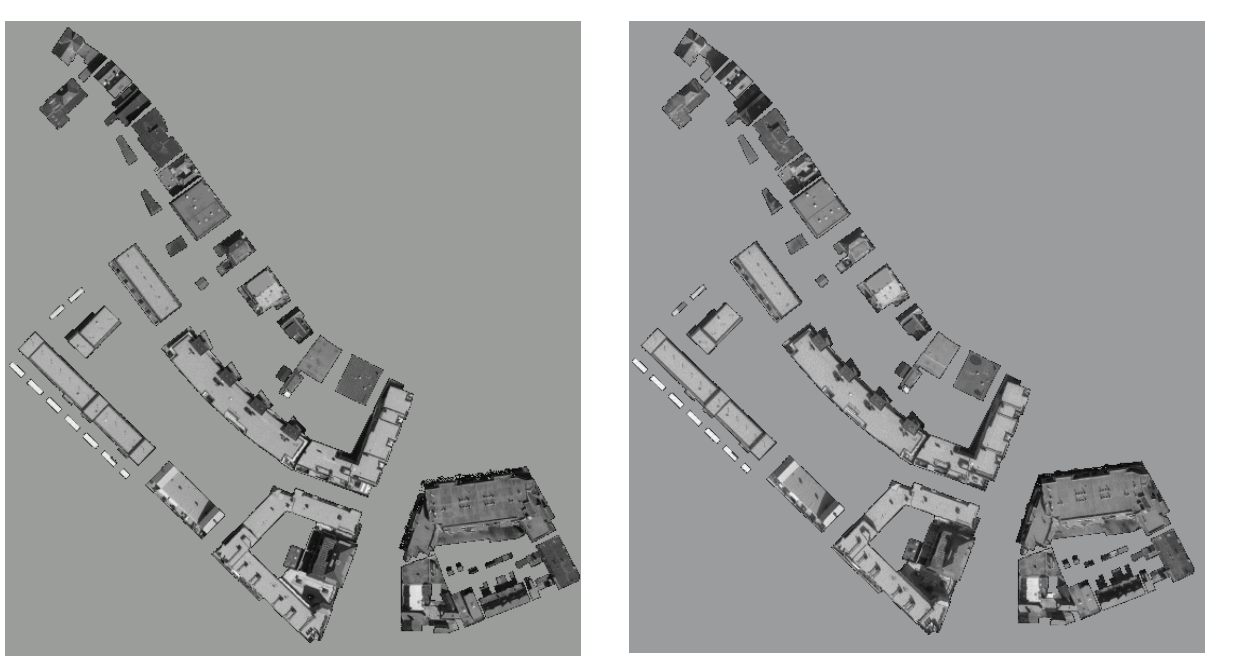
Figure 4: Building (roof) objects 2011